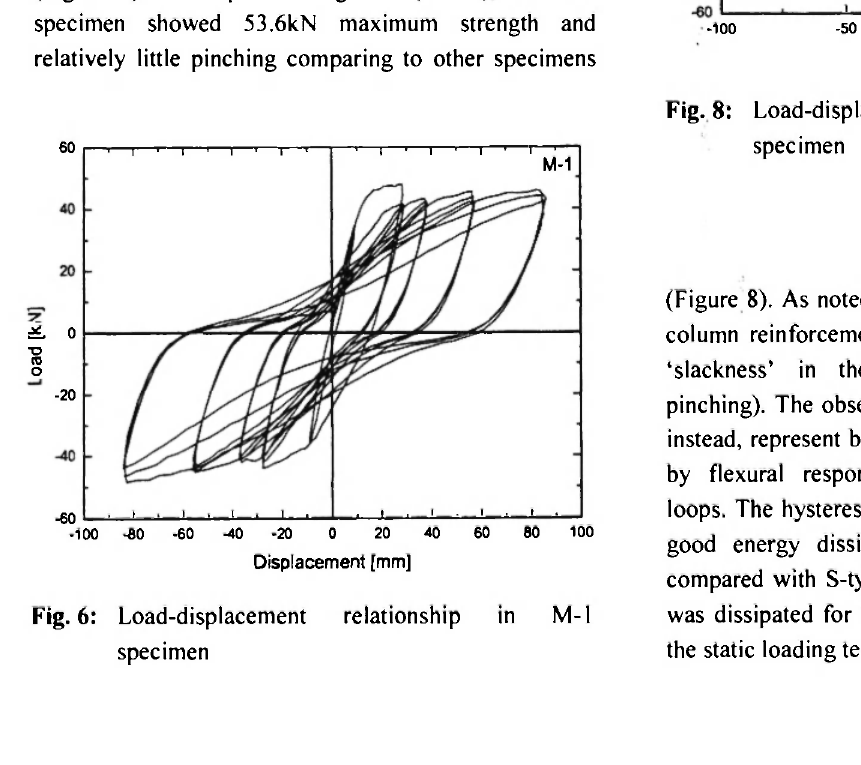
Fig. 8: Load-displacement relationship in M-3 specimen